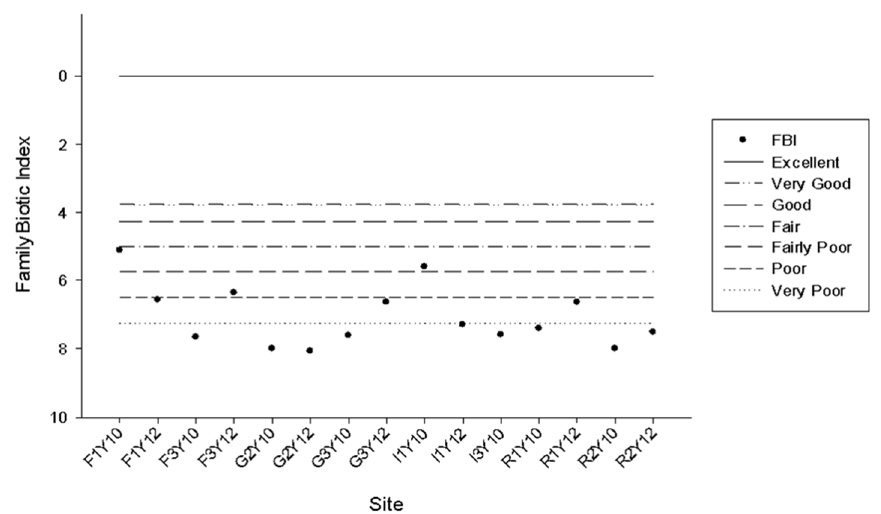
Figure 5. Family Biotic Index (FBI) scores calculated from FWI samples collected from the 8 LULC reaches in the Neponset River Watershed in 2010 and 2012. Note: for FBI, lower values indicate better water quality; higher values indicate poorer water quality (F = Forest, G = Golf, I = Industrial, R = Residential; Y10 = 2010, Y12 =2012).